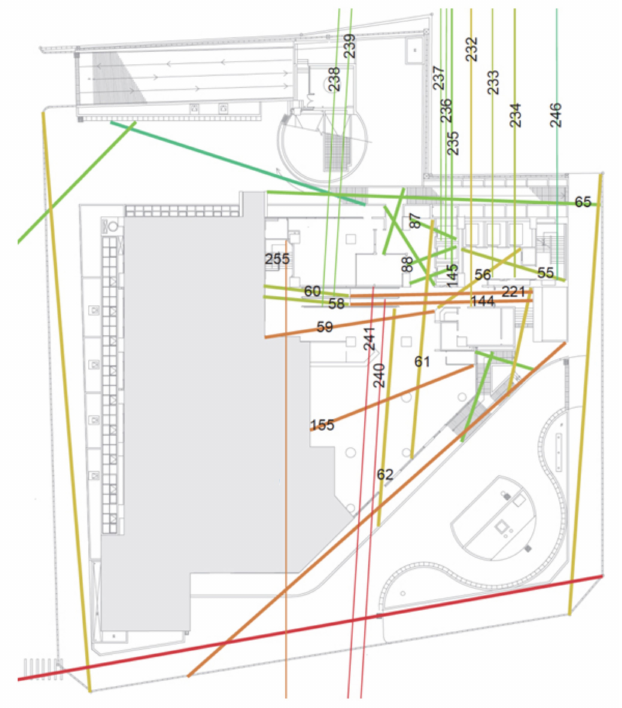
Figure 6. The axial mapping analysis of the first floor of the CCH/CKB